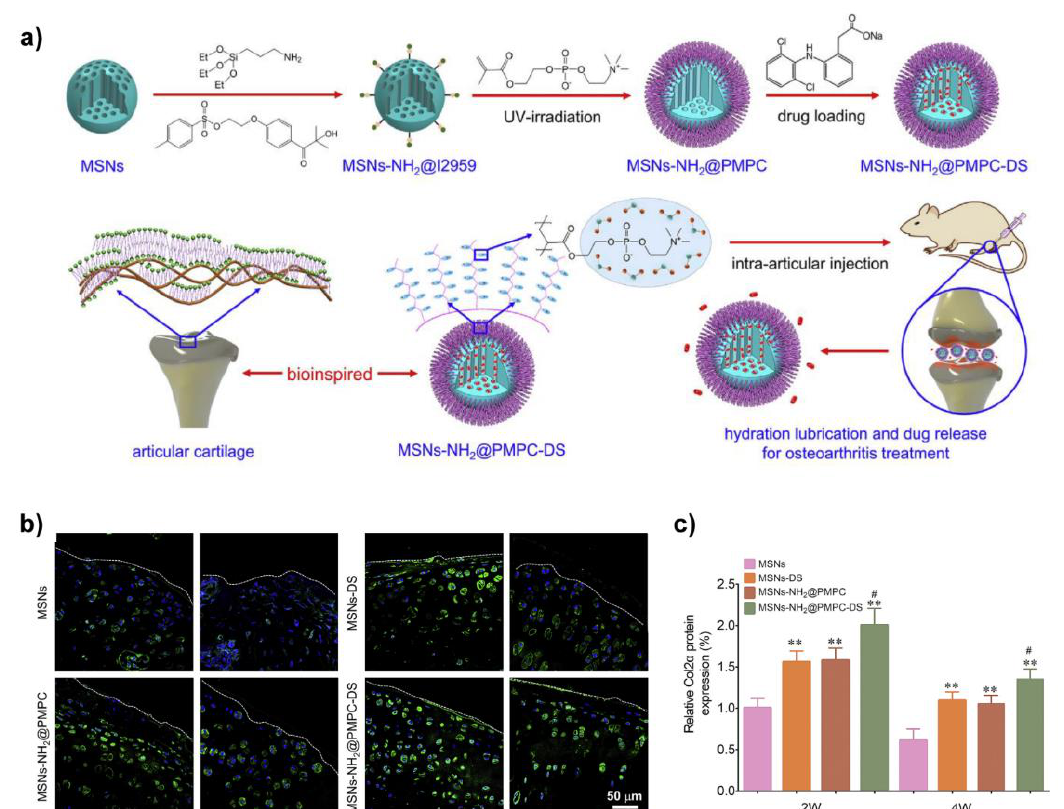
Figure 7. ( a ) Schematic of the preparation of MSNs-NH 2 @PMPC-DS with the aim to lubricate and treat OA; ( b ) Representative images of immunohistochemistry staining of the expression level of Col2α estimated by the surgery-induced OA rats; ( c ) The quantitative level of Col2α was obtained based on fluorescence intensity in Figure 7b, n=5 and the data were presented as mean ± SD, **P < 0.01, MSNs as the control group, # P < 0.05, MSNs-DS as the control group. Reprinted with permis- sion from ref. [109]. Copyright 2020 Elsevier.